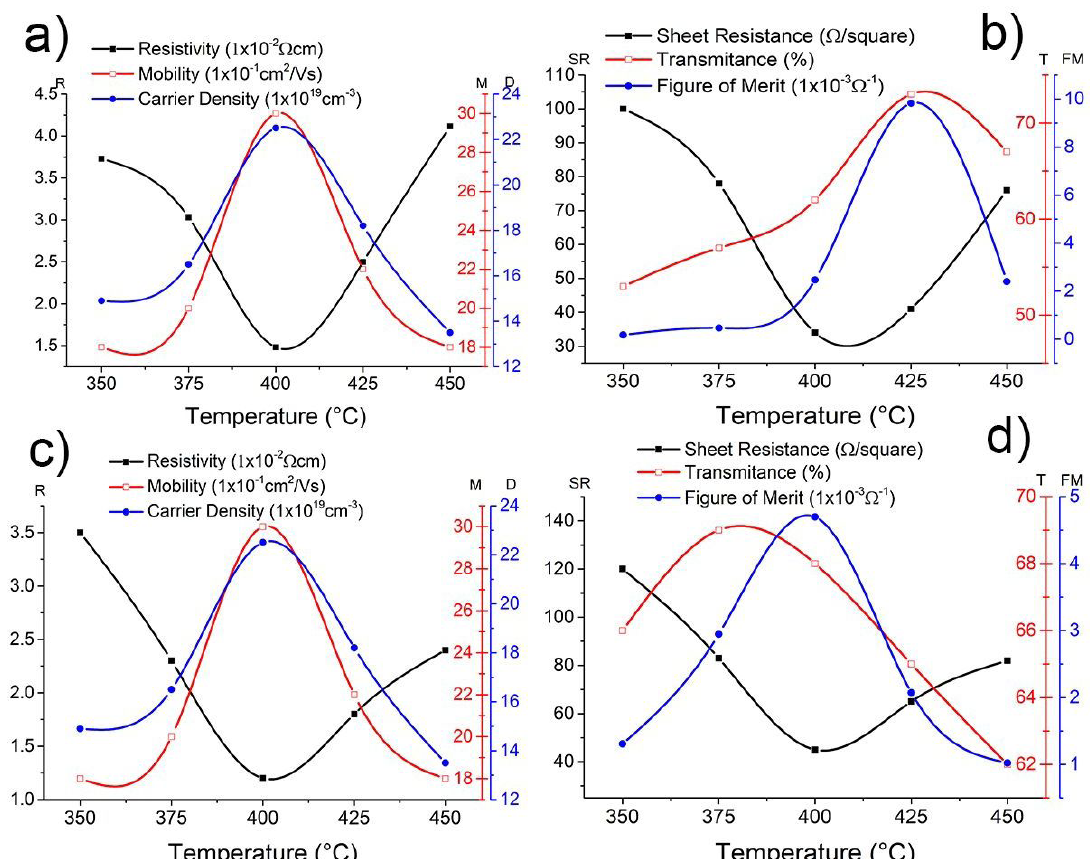
Figure 3. Variation in the electrical and optical properties of ATO thin films annealed at different temperatures (350°C to 450°C) (a,b) annealed in N2 and (c,d) Forming gas atmospheres.